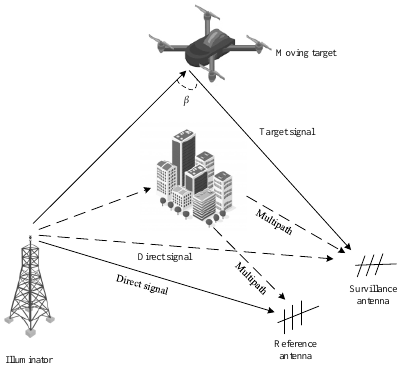
Figure 1. PBR system model.